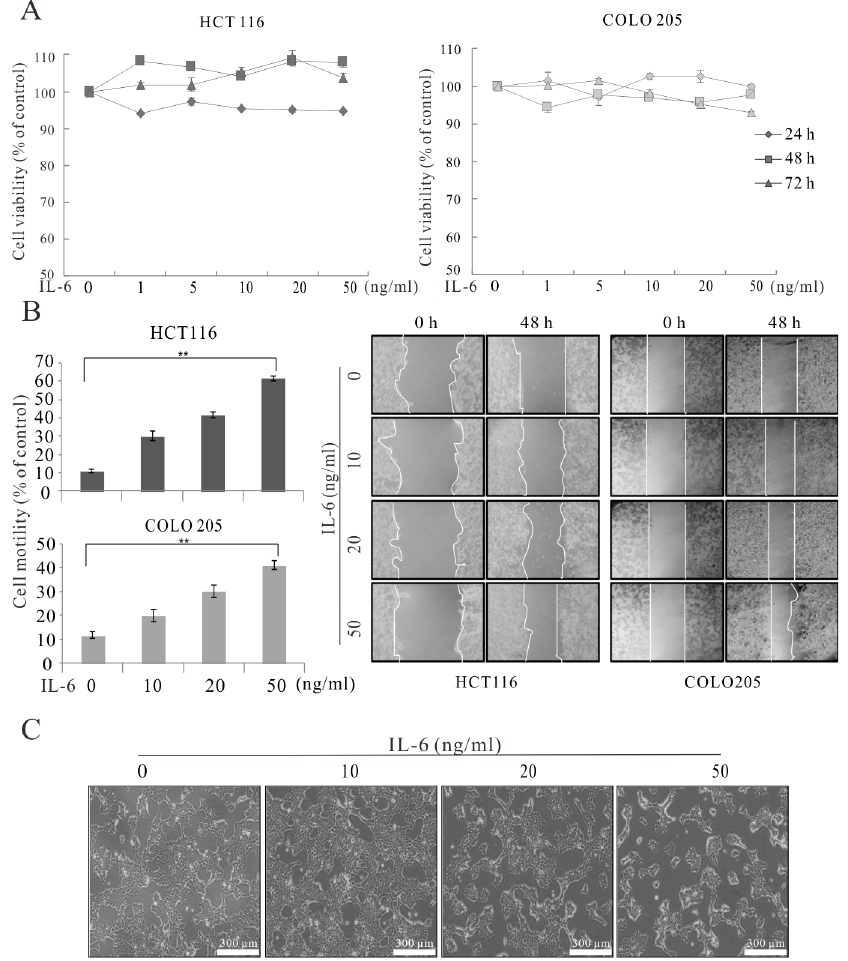
Fig 3. IL-6 induced EMT in colon cancer cells. (A) Cell viability assay for colon cancer cell lines. (B) Migration assay for colon cancer cell lines treated with different concentrations of IL-6 for the indicated times. (C) Morphological changes in colon cancer cells upon treatment with IL-6 at the indicated concentrations. Scale bar = 300 μ m, HCT 116. (cid:3) p < 0.05, (cid:3)(cid:3) p < 0.01.